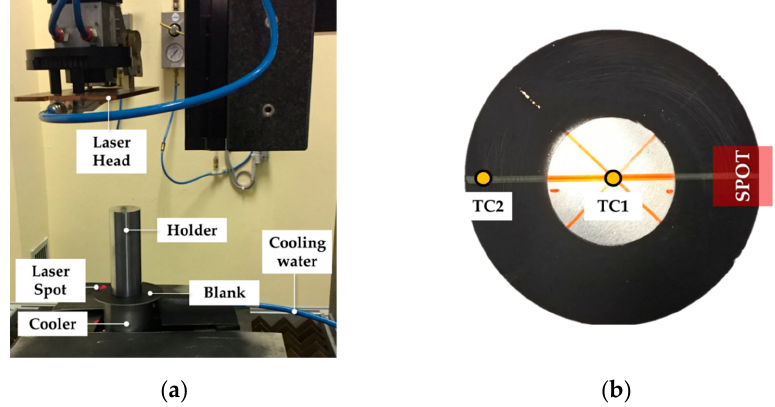
Figure 6. Local laser treatment: ( a ) 102 mm diameter blank preparation, ( b ) experimental setup.